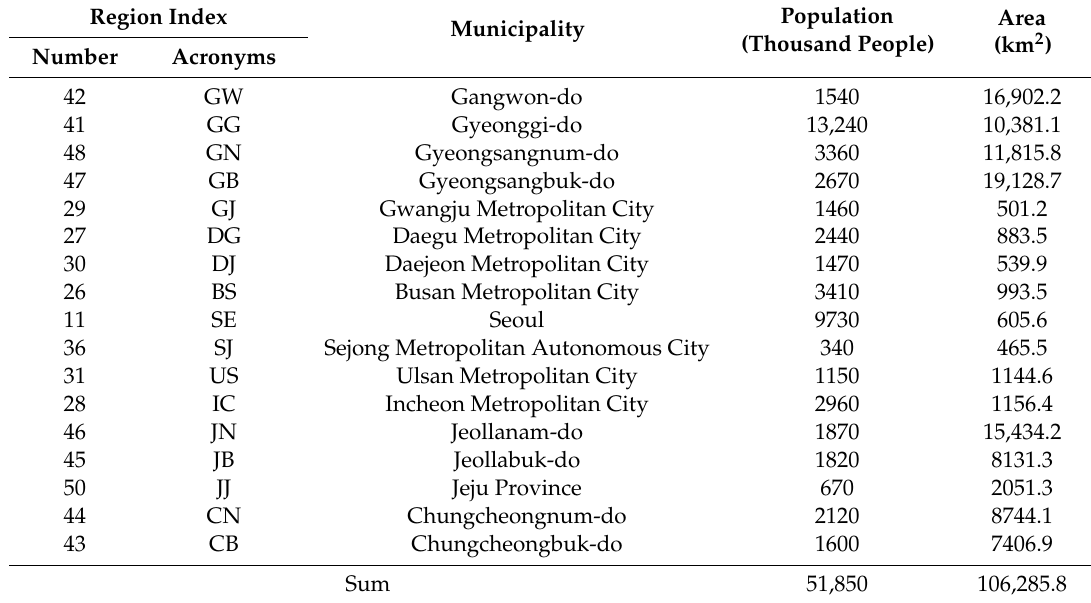
Table 1. State of study